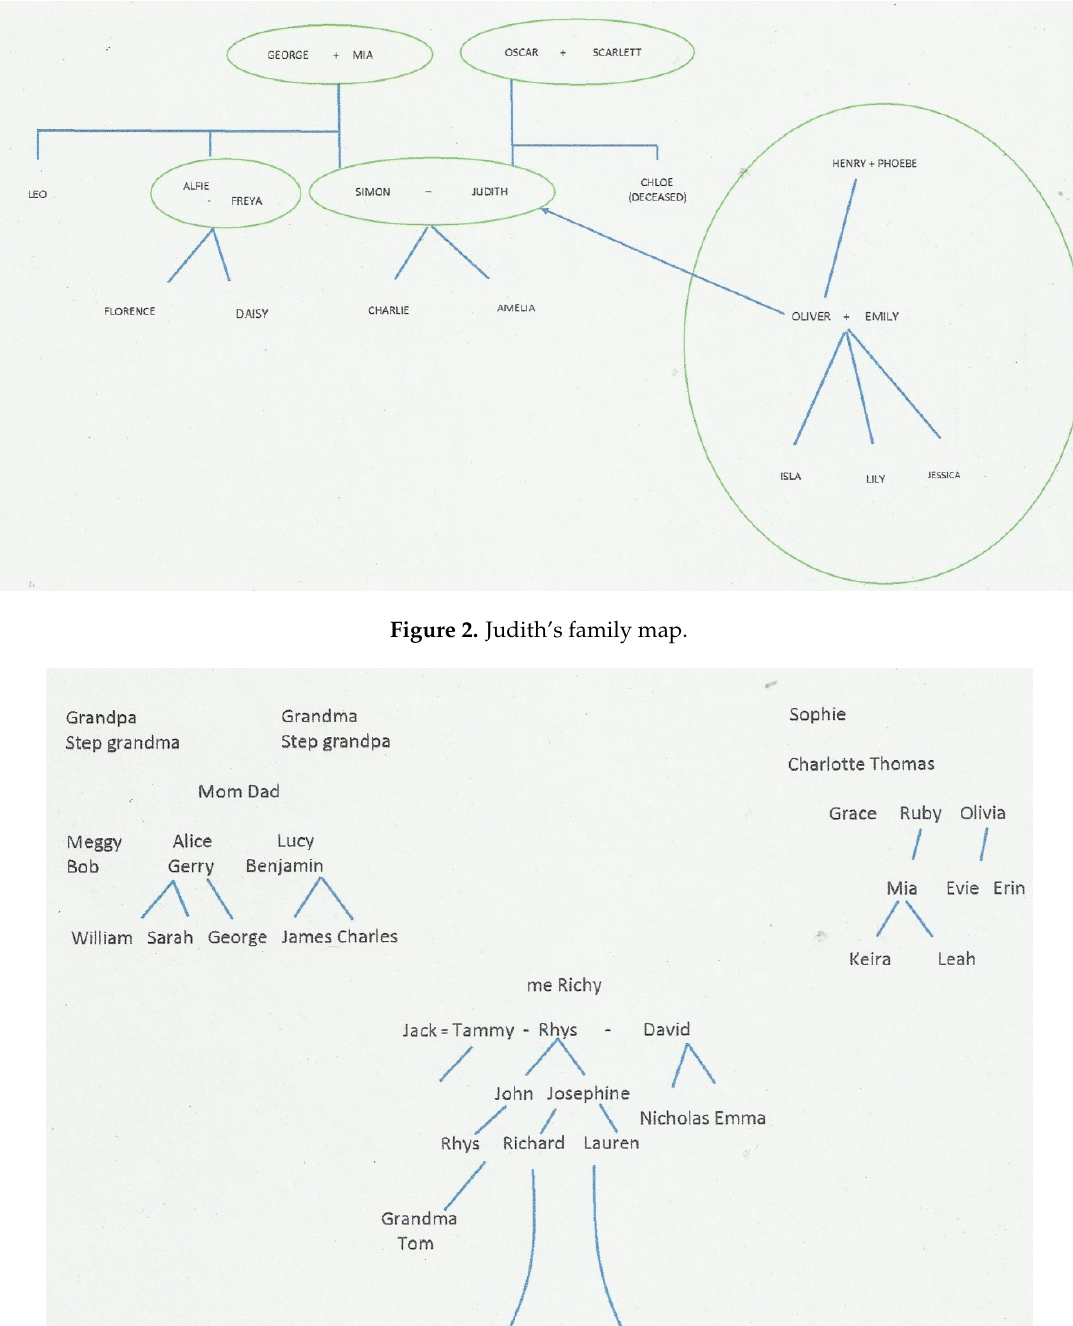
Figure 1. Ella and Jamie’s family map.